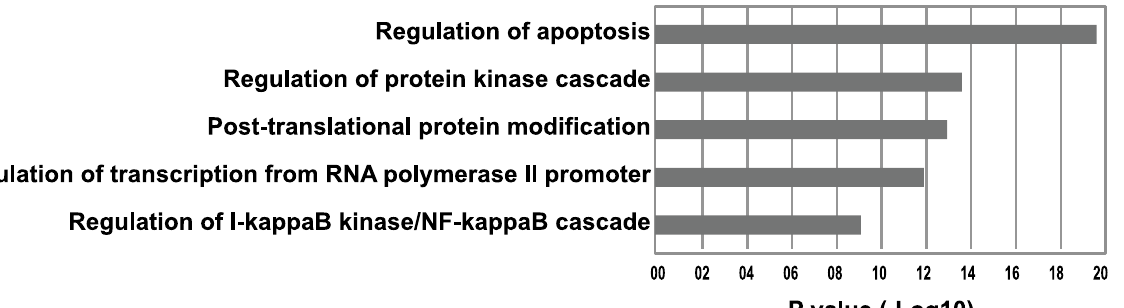
Figure 5. Functional validation of cellular proteins from the MHV-68-cellular protein interaction network. A) Overview of the functional validation approach used to evaluate the effect of cellular interacting proteins on MHV-68 replication. HEK293T cells were reverse transfected with siRNAs targeting cellular genes and infected with M3-Luc MHV-68, which provides a sensitive and conveniently assayed measure of virus replication. The supernatant was collected at 50 and 58 h post-infection and used to infect fresh 293T cells. Luciferase activity was measured at 20 h post- infection. (B) The effect of inhibiting expression of cellular proteins from the Y2H-High priority group (Y2H-HP) on MHV-68 replication. Expression of